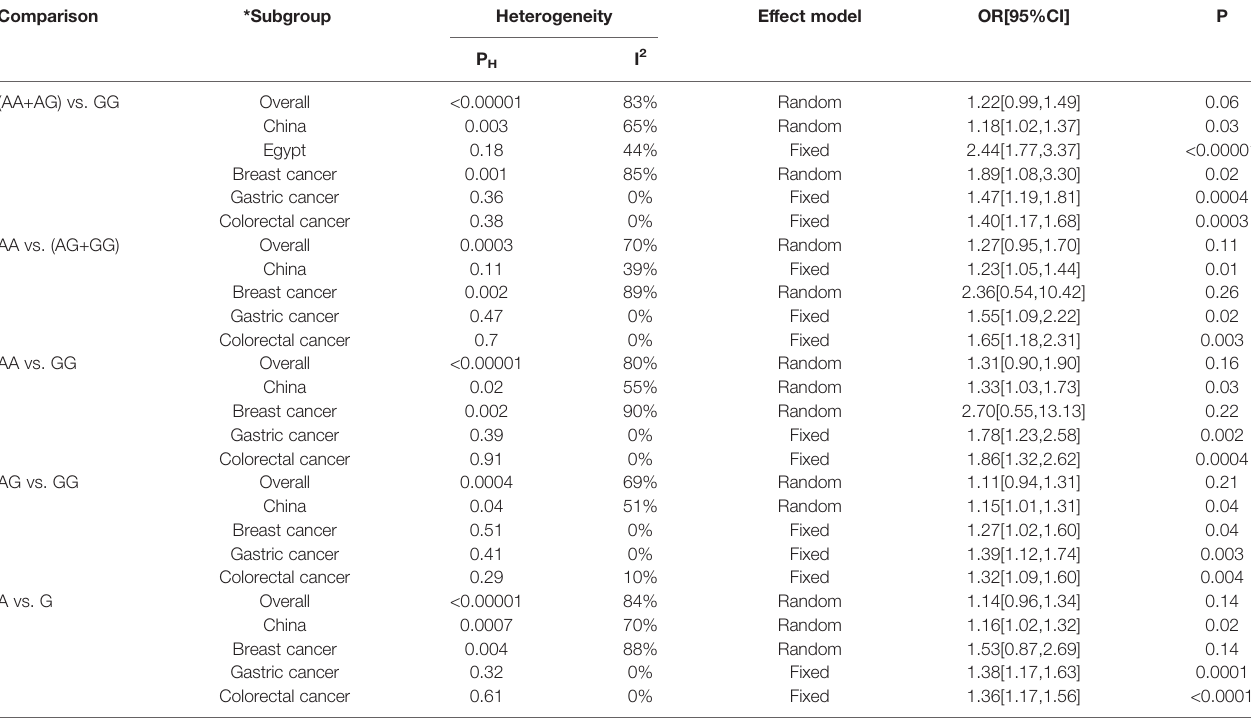
TABLE 3 | Meta-analysis of the association between the rs7158663 polymorphism and cancer risk. Comparison